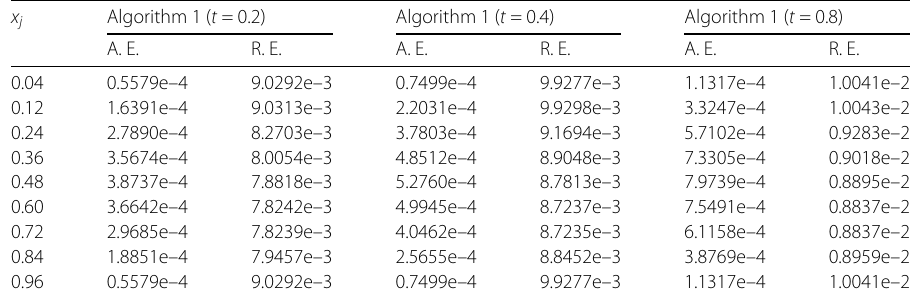
Table 3 The absolute errors and relative errors of numerical solutions to Example 1 for h = 1/25 (i.e., m – 1 = 24 = 6 K , K = 4)